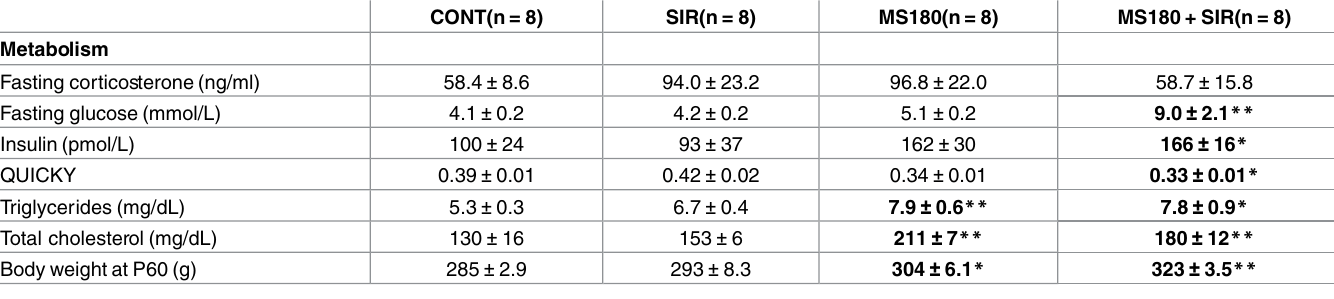
Table 1. Socialisolation rearing inducesmetabolic syndromein MS180